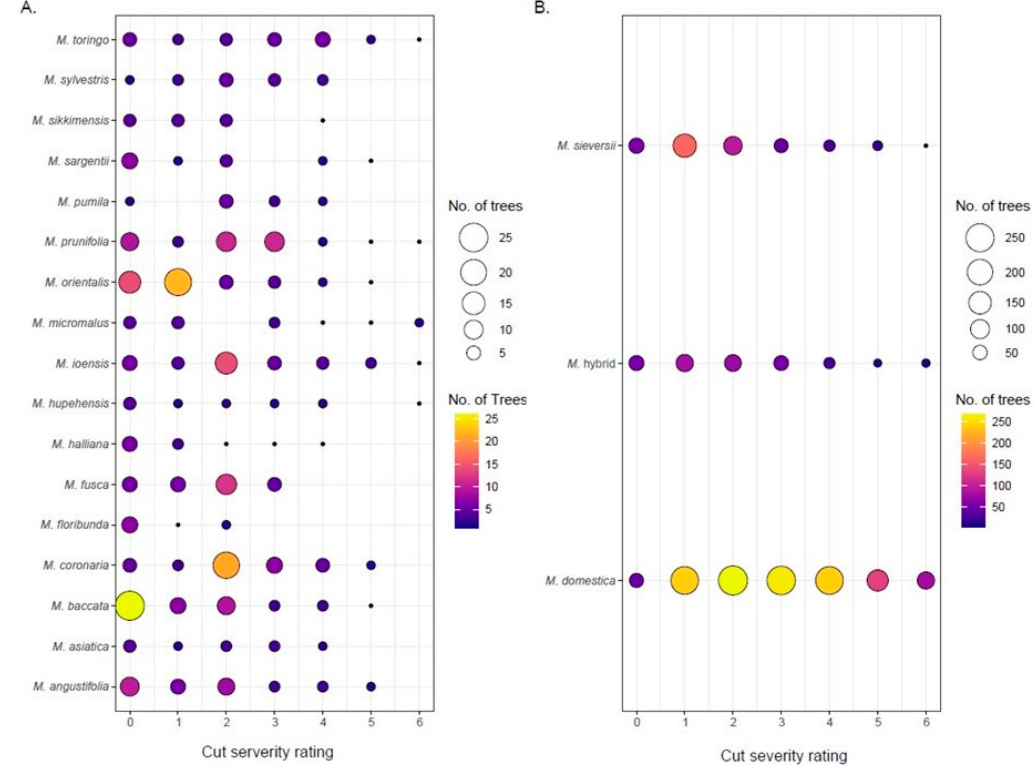
Figure 8. Main collection cut severity ratings with species containing >10 trees. ( A ) Wild species ( B ) M. domestica, Malus hybrid and M. sieversii. Circle sizes indicate the number of trees, as do the corresponding colors.